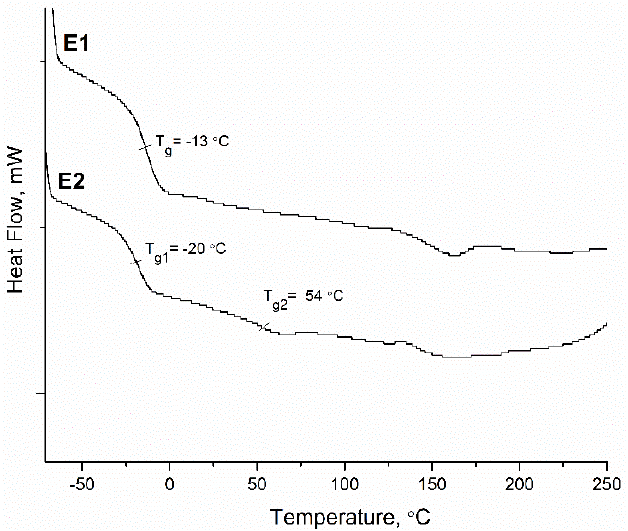
Figure 4. DSC thermograms of random copolymer latex (E1) and composite core—shell acrylic latex (E2).